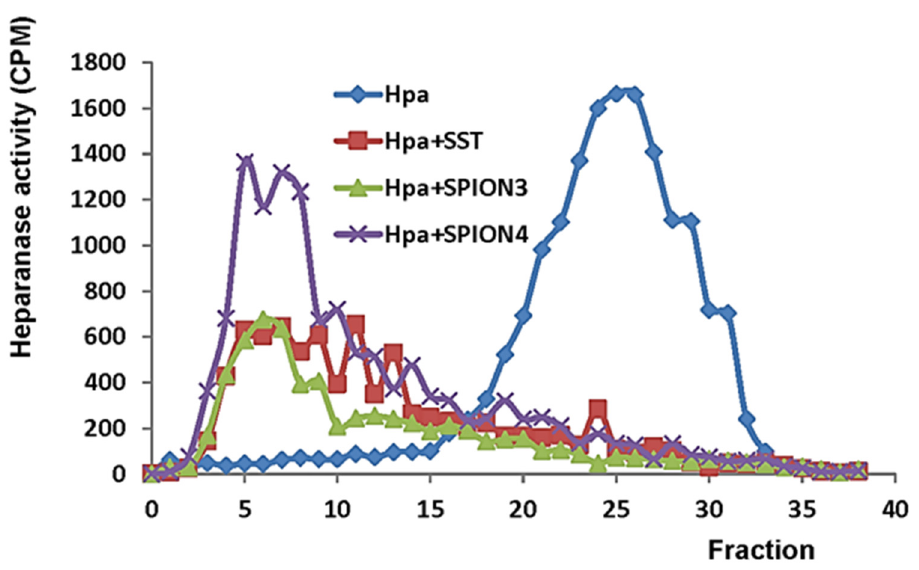
Figure 8. The LMWH@SPIONs SPION3 and SPION4 effectively inhibit the heparanase-mediated liberation of H35S fragments from basement membrane H35SPGs. The compounds were first incubated with recombinant heparanase for 30 min at 4 ◦ C followed by incubation (6 h, 37 ◦ C) with the sulfate-labeled ECM in the absence (Hpa, 200 ng/mL) and presence of SST0001 (10 µ g/mL), SPION3 (200 µ g/mL), or SPION4 (200 µ g/mL). Sulfate-labeled degradation fragments released into the incubation medium were subjected to gel filtration on Sepharose 6B as described in the ‘Materials and Methods’. HS degradation fragments are eluted in fractions 18–33.